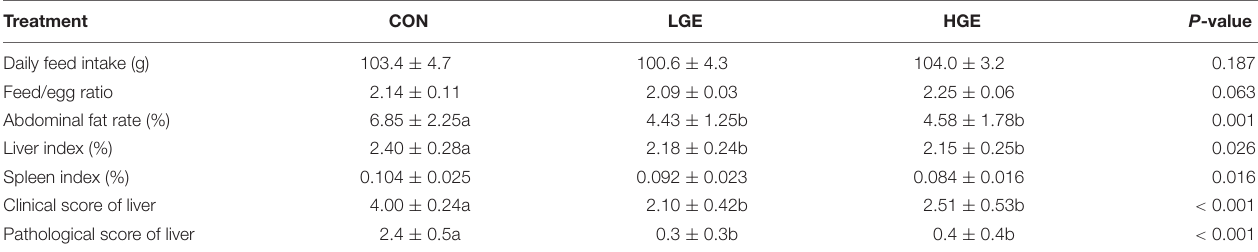
TABLE 3 | Effect of dietary GEN on feed/egg ratio, daily feed intake, organ indices, and liver scores in hens.